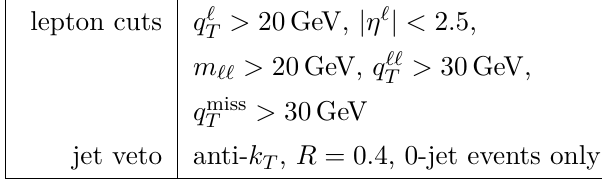
Table 7 . Setup for the CMS W + W − fiducial volume analysis at